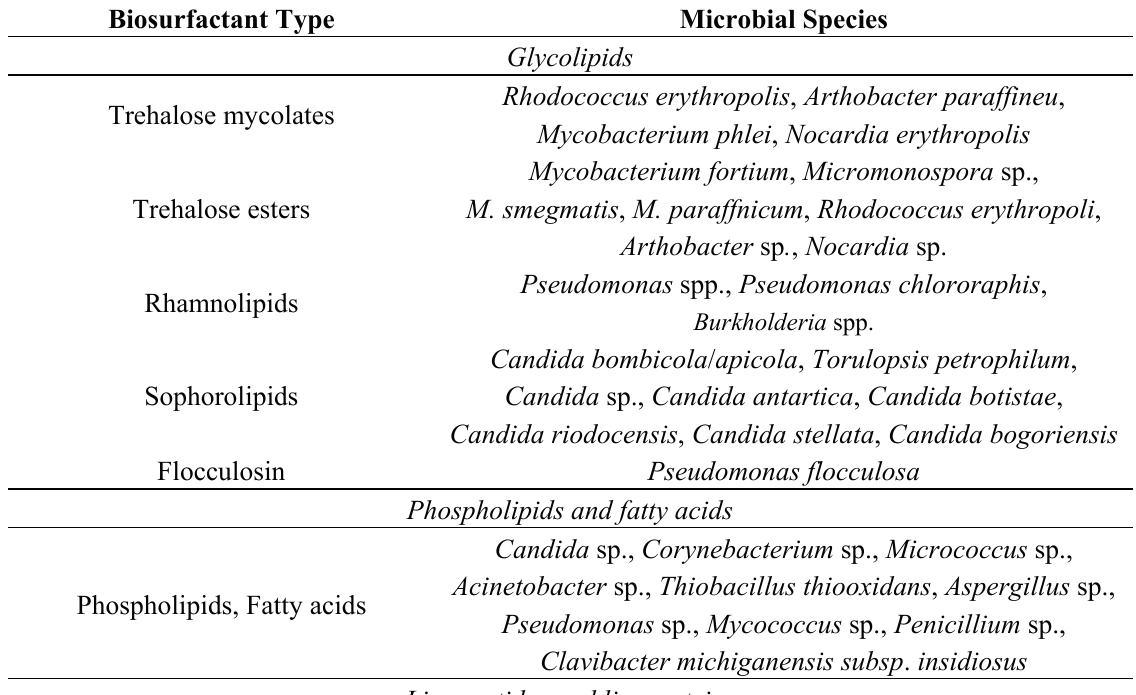
Table 2. Various biosurfactants produced by